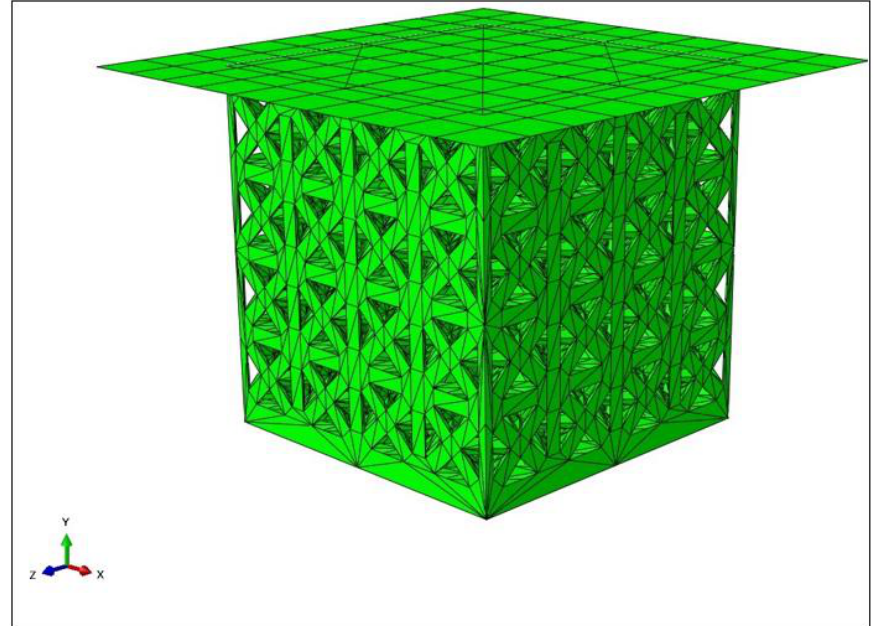
Figure 4. Assembly of plate and Lattice 1 sample as set up in Abaqus.